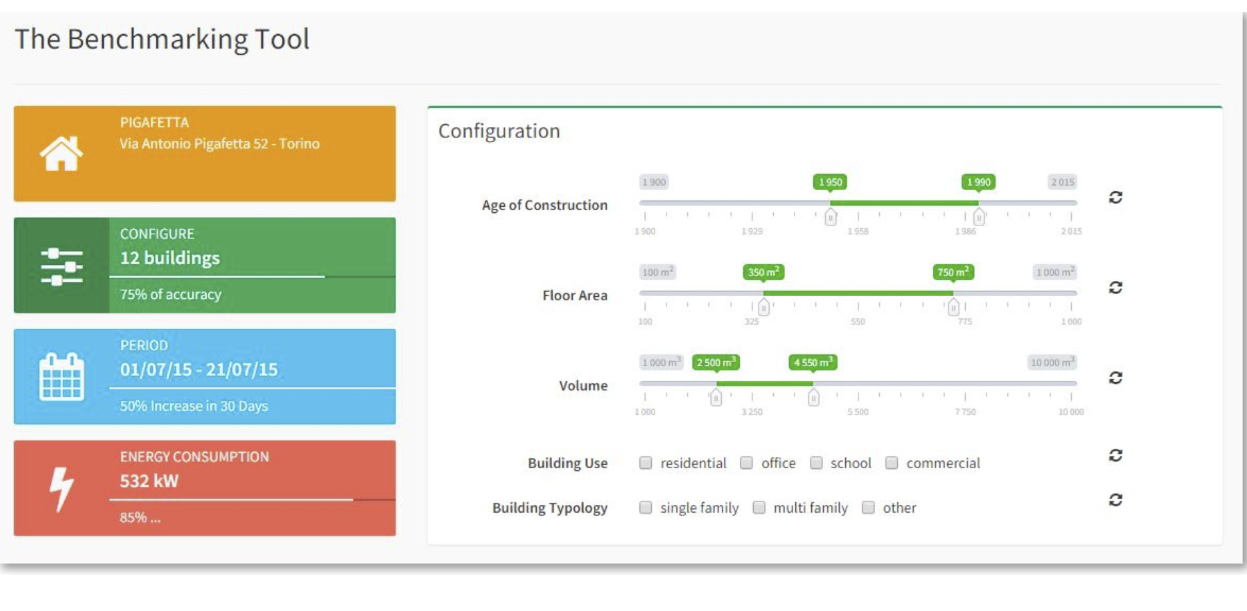
Figure 6. Benchmarking tool